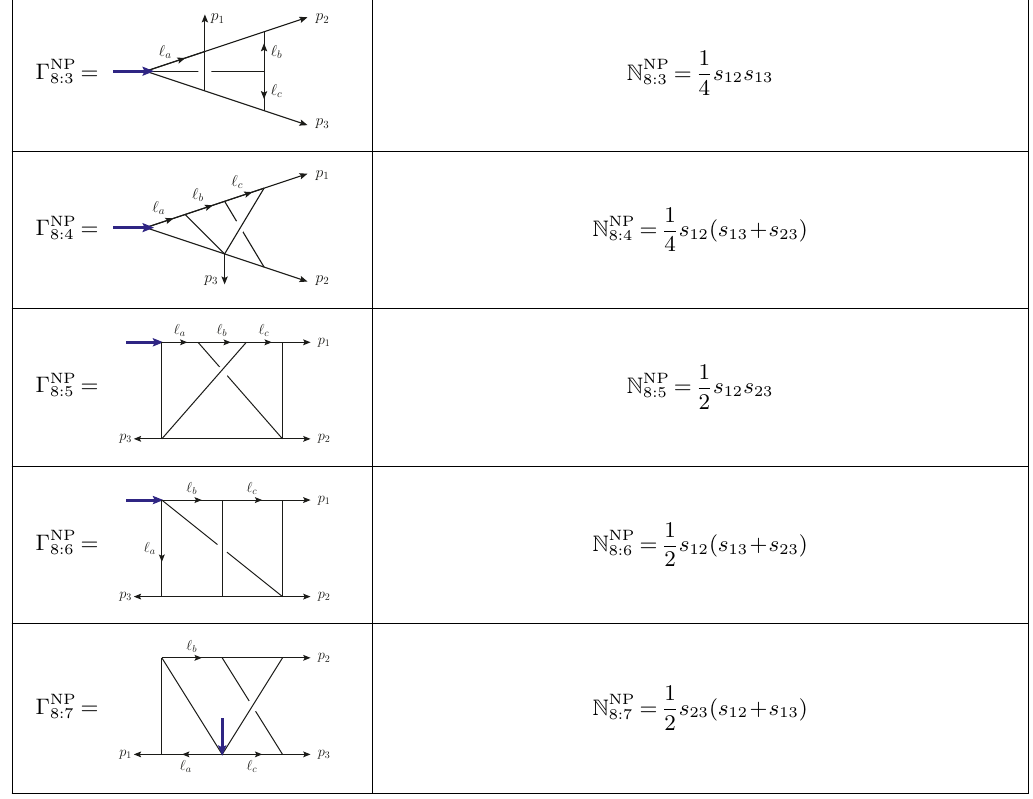
Table 4. N c -subleading tr( φ 2 ) form factor results in